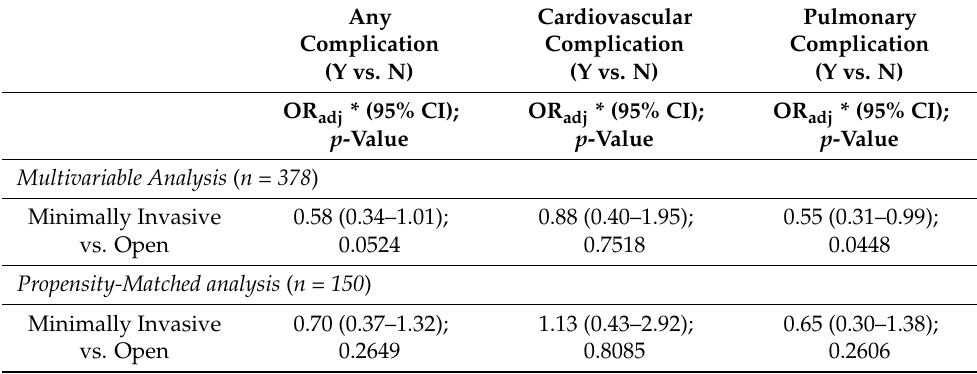
Table 6. Odds of complications in minimally invasive vs. open P/D patients, multivariable and propensity-matched